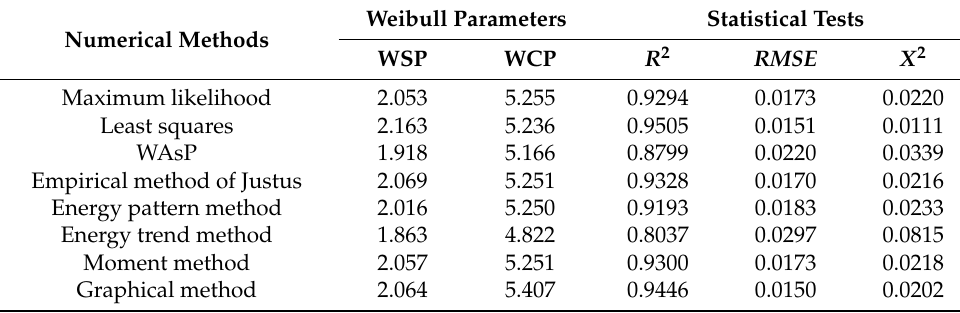
Table 7. Weibull parameters and statistical analysis for